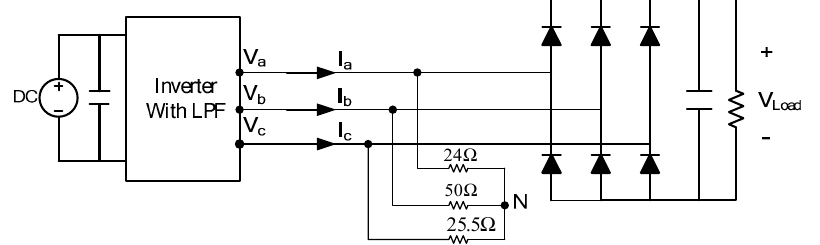
Figure 20. System configuration of the three-phase inverter serving both unbalanced and nonlinear loads.